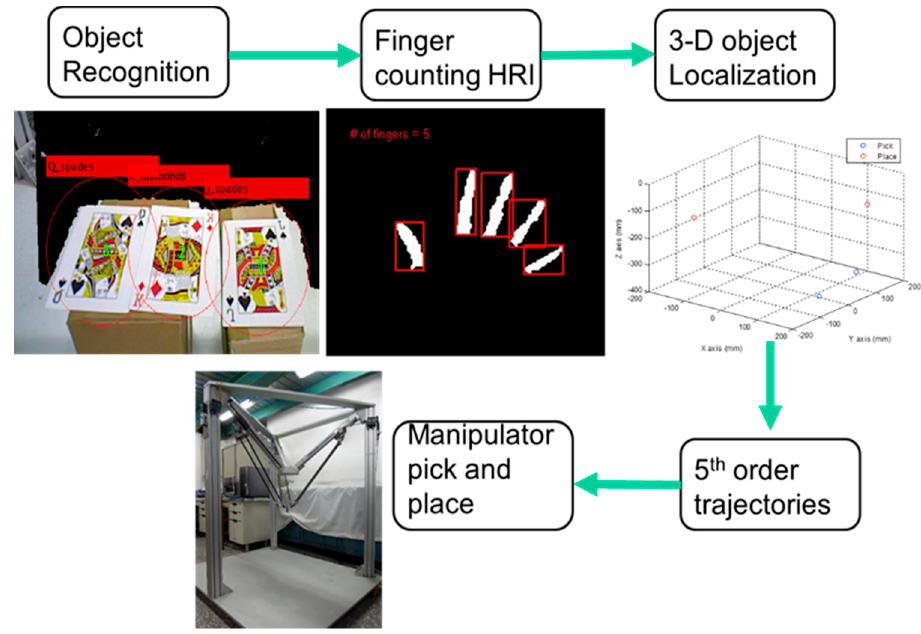
Figure 14. The experiment process.